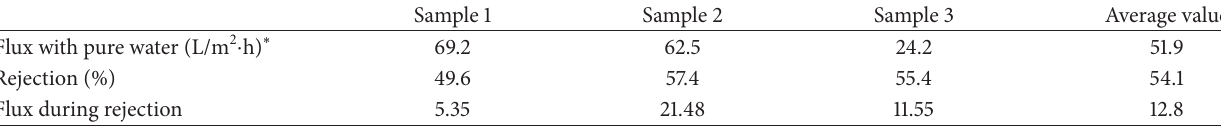
Table 3: Flux and rejection values of membrane.